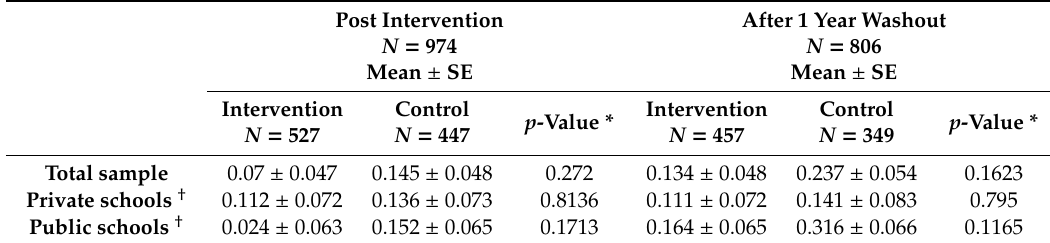
Table 2. Change in mean BMI Z-score in intervention and control groups relative to baseline at post-intervention and after washout.